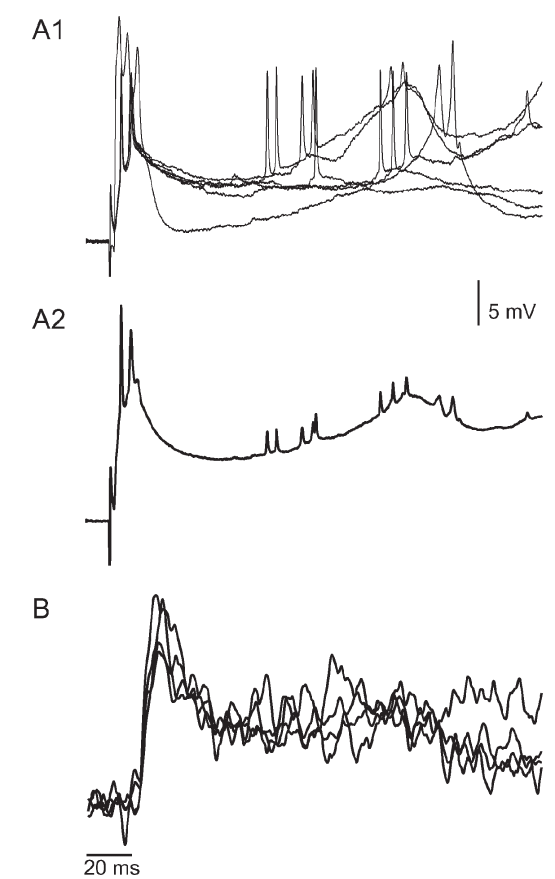
Figure 2. The voltage correlates of the prolonged positive optical signals. ( A ) Six superimposed traces of intracellular recordings from a PC dendrite (A1) and their average (A2), showing the response to CF stimulation. Note that the initial brief response is followed, after a variable delay, by a prolonged wave of depolarization that occasionally reached threshold and generated a short burst of action potentials. ( B ) An optical recording from a different experiment showing a waveform similar to that of A2. Traces from four diodes are